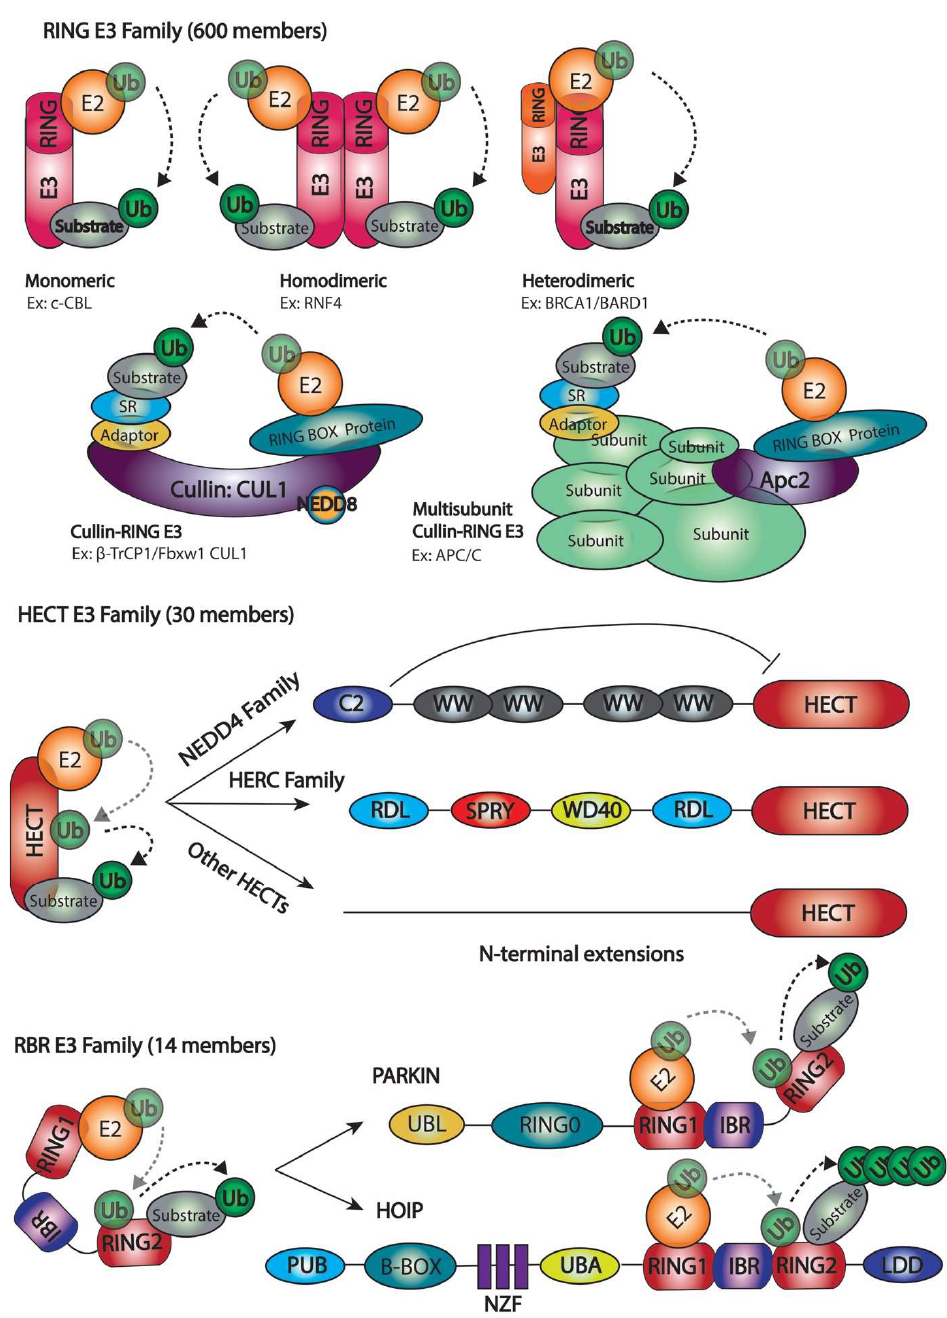
Figure 3. The E3 enzyme families and subclasses. RING E3 enzymes are shown as monomeric, homodimeric, heterodimeric, and forming multi-subunit complexes (CULLINs) E3 enzymes. HECT E3 enzymes are exhibited in three sub-families: NEDD4 Family, HERC Family, and Other HECT. RBR E3 Family is a 14 members family where two members are shown (PARKIN and HOIP), and the ubiquitination mechanism is displayed. The ubiquitination process is depicted. While the Ub transfer from the E2 to the substrate occur in a 2-step reaction for HECT and RBR families, there is a direct ubiquitin transfer from the E2 to the substrate in the RING E3